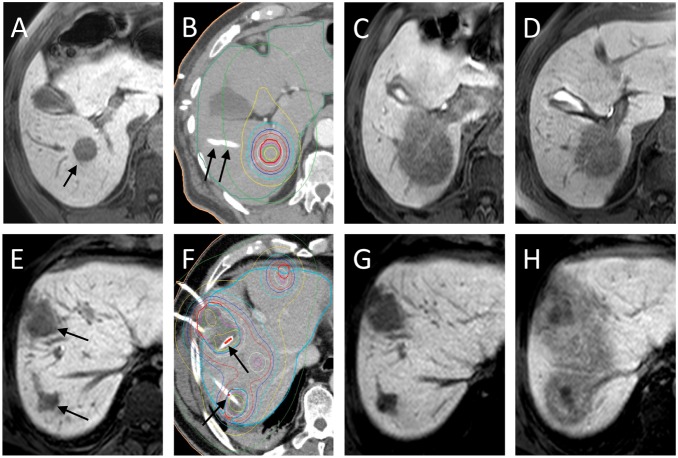
T1w-axial THRIVE 20 min after application of Gd-EOB-DTPA (A, C–E and G, H) and BT planning CT with dosimetry (B and F).A–D, control group. A: pre-treatment MRI displaying a metastasis scheduled for BT treatment (black arrow). B: Planning-CT after introduction of the brachytherapy catheters (black arrows). Clinical target volume (CTV) represented by bold red circle and dosimetry by coloured lines (red: 20 Gy-, blue: 12 Gy-isodose). C: MRI at 6 weeks showing substantial reduction in Gd-EOB-DTPA uptake by liver parenchyma adjacent to treated metastases (i.e. focal radiation-induced liver injury, fRILI). Note: The area of fRILI matches the geometry of the dosimetry (B). Determined threshold dose: 9.75 Gy. D: MRI at 3 months showing shrinkage of the fRILI. Determined threshold dose: 11.9 Gy. E–H, treatment group. E: pre-treatment MRI displaying two metastases (black arrow); two more treated lesions are not displayed in the plane. F: Planning-CT (annotations: see B). G: MRI at 6 weeks showing no fRILI. H: MRI at 3 months after radiotherapy (and 1 month after finishing study treatment) showing a substantial region of fRILI. Determined threshold dose: 15.8 Gy.